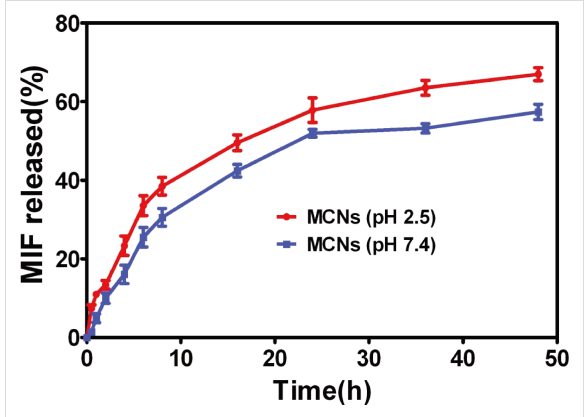
Figure 6: In vitro release profiles of MIF from MCNs at pH 2.5 and 7.4. The release of MIF from the dialysis tube containing MCNs immersed in 0.1 M PBS (pH 7.4) or 0.1 M PBS (pH 2.5) containing 1% of ethanol.